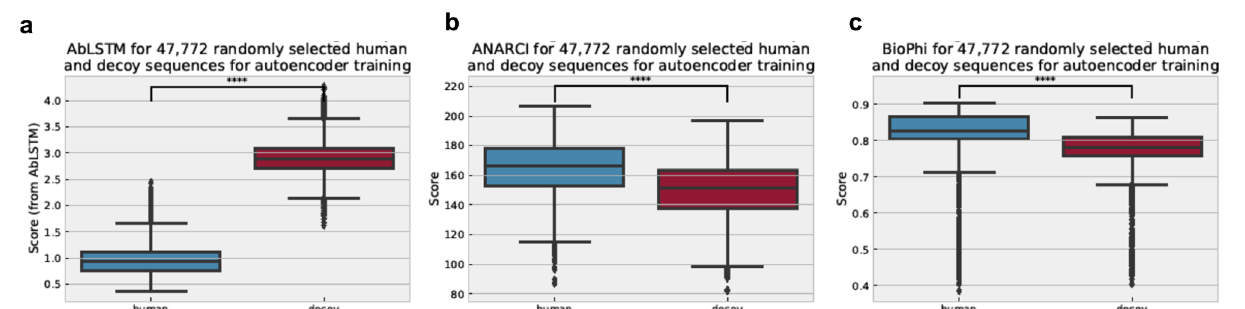
Fig. 5 | Scoring the human-ness of decoys and original sequences from the autoencoder training set. We randomly sampled 47,772 sequences from the autoencoder training set (half decoy, half human). We then score these for human-ness using a the AbLSTM model, b the ANARCI tool and c the BioPhi model from the literature. In all three cases, the model ’ s score for decoys is signi fi cantly different from that for non-decoys, and the decoys are less